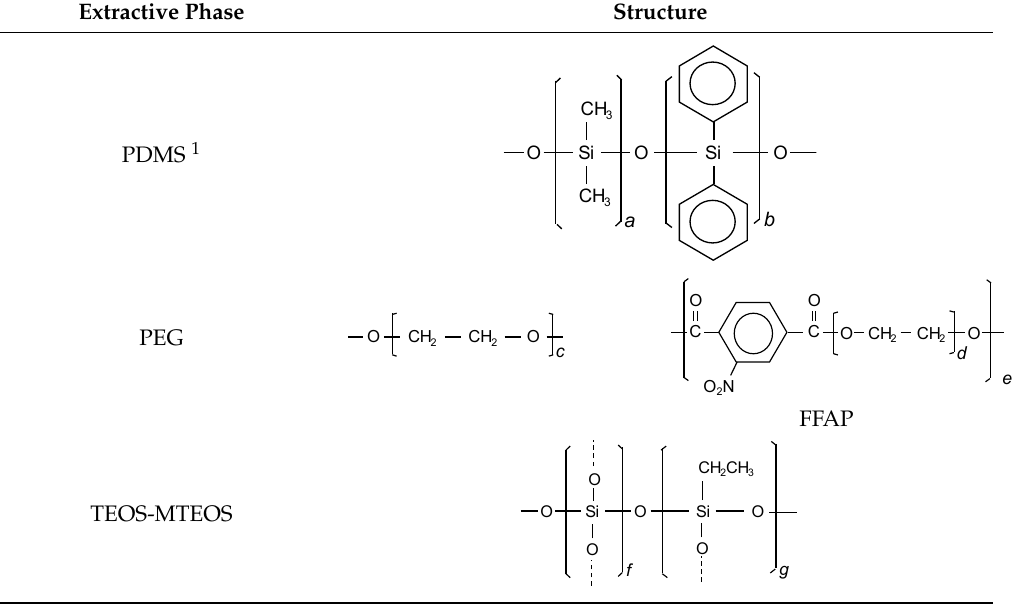
Table 2. Structure of the polymeric coatings tested.